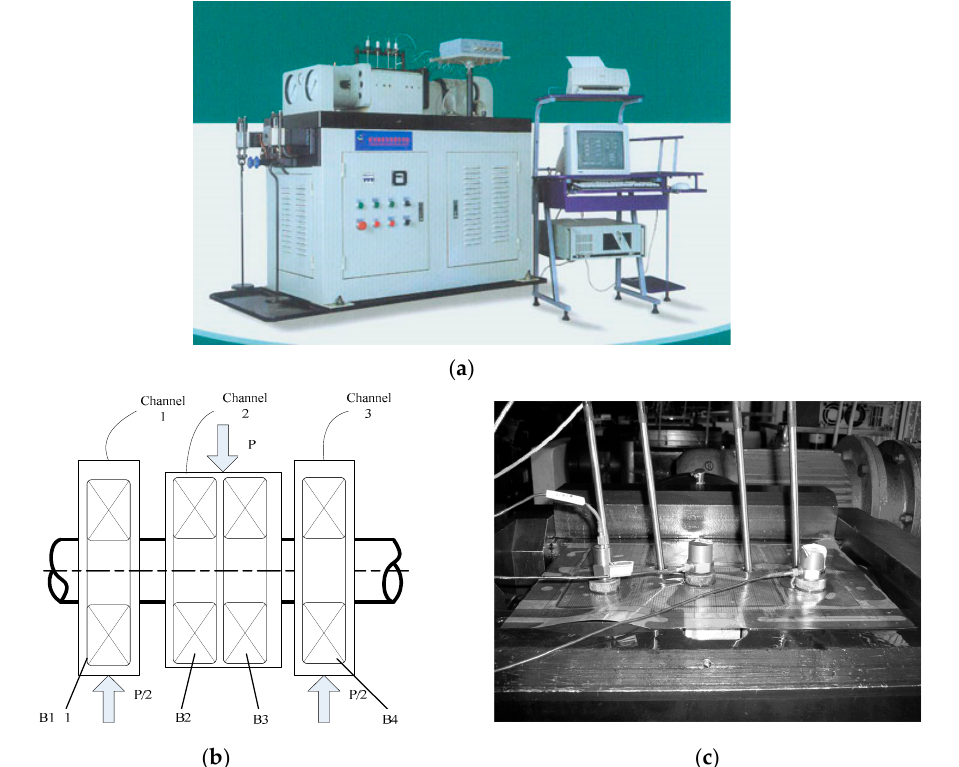
Figure 6. Accelerated life test of rolling element bearing. ( a ) Accelerated bearing life tester, ABLT-1A; ( b ) sketch of load; ( c ) location of sensors.